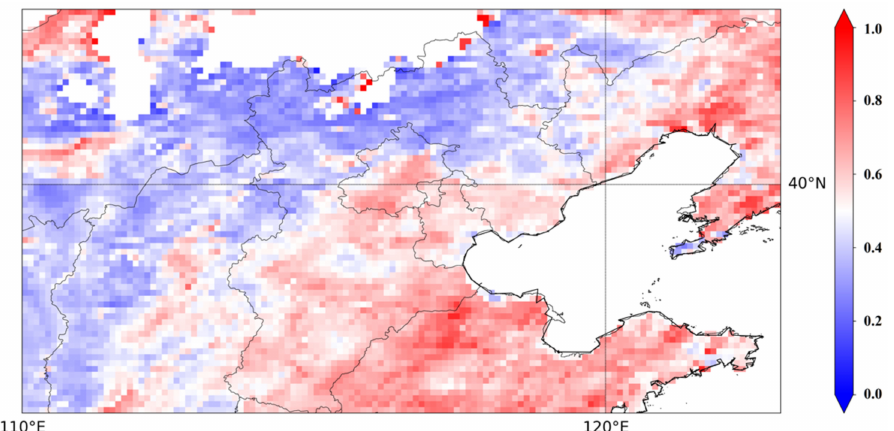
Figure 4. Monthly mean fine-mode fraction by volume in January 2012 as retrieved from POLDER- 3/PARASOL satellite